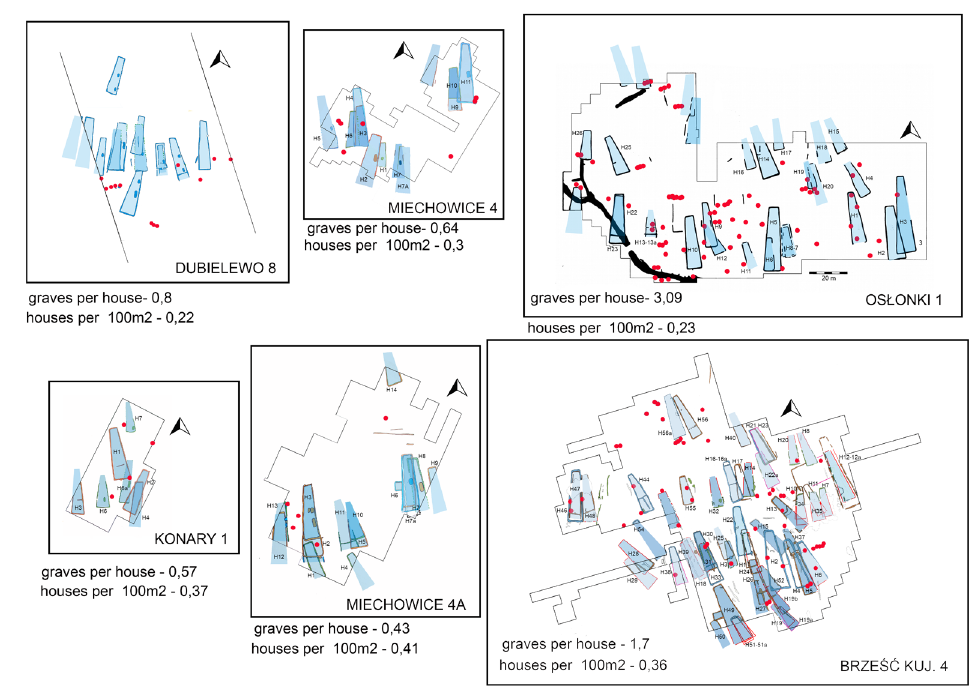
Fig. 5 . Houses and graves on BKK settlements at Dubielewo 8, Miechowice 4, Osłonki 1, Konary 1, Miechowice 4a and Brześć Kujawski 4. According to: Mikulski and Siewiaryn 2011; Grygiel 2008, modified by the